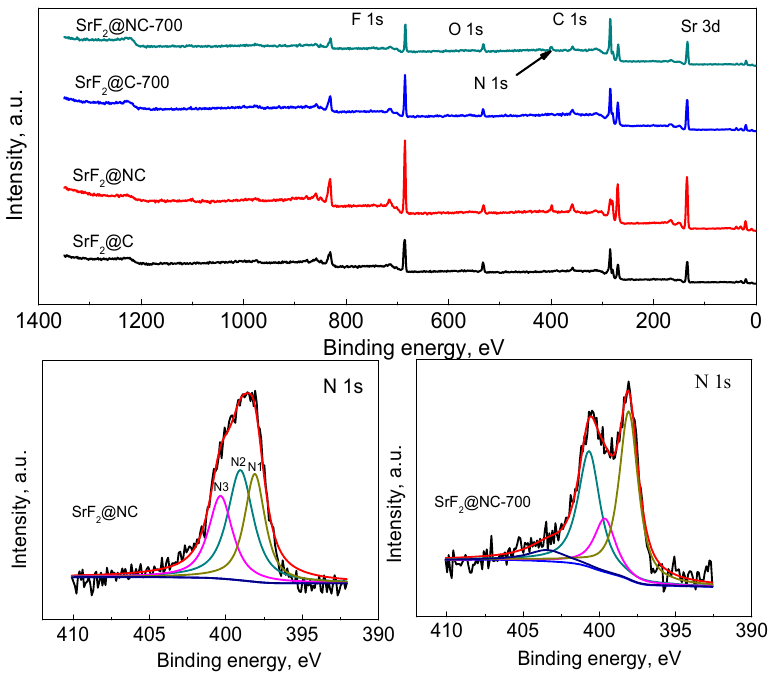
Figure 10. XPS spectra of SrF 2 @C, SrF 2 @C-700, SrF 2 @NC, and SrF 2 @NC-700 catalysts.